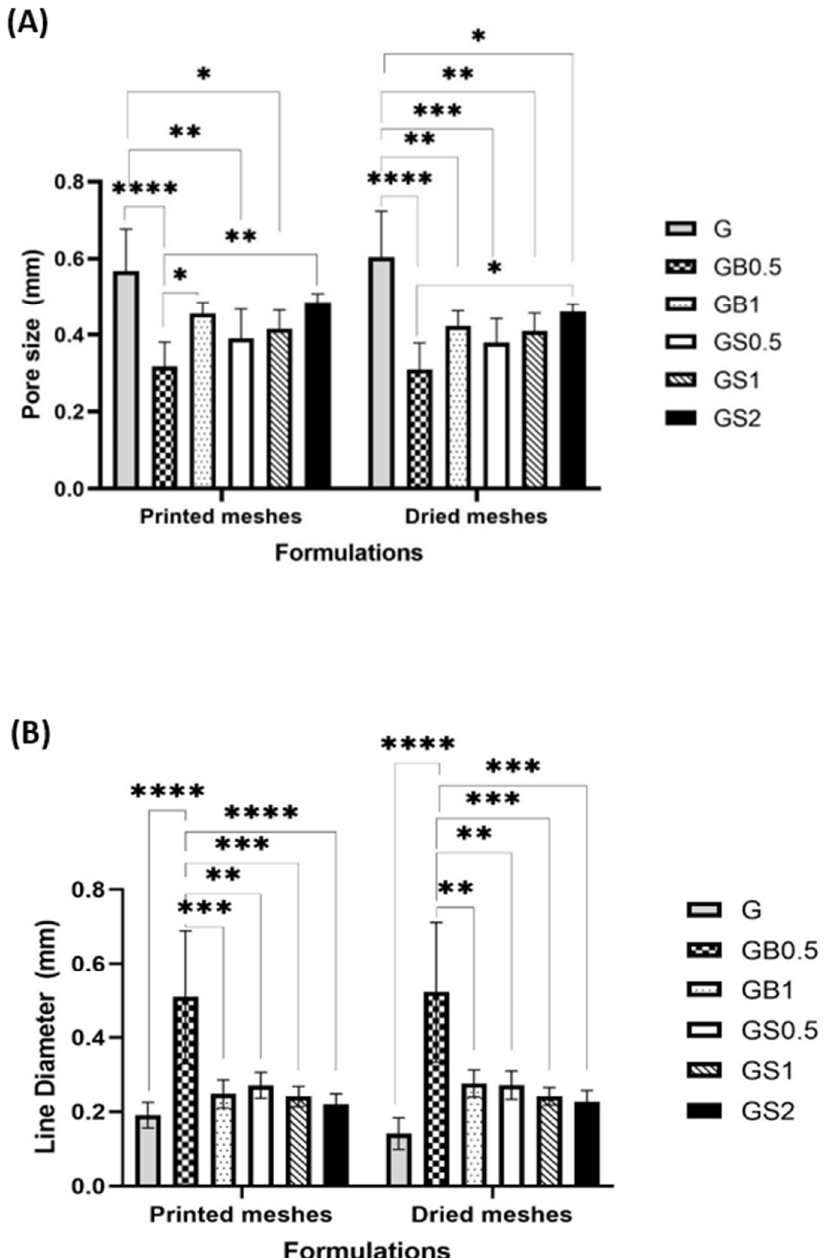
Figure 7. Comparison of ( A ) pore size and ( B ) line diameter of all the meshes before and after vacuum drying, printed using 25 G needles (**** p < 0.0001, *** p < 0.001, ** p < 0.01, * p < 0.05). The line diameter was found to be inversely associated with the pore size of the hy- drogel meshes; this is because the space occupied by thicker printed lines reduces the pore size of the printed mesh. Both printed and dried GB0.5 meshes were found to have larger diameter lines and smaller pores than other formulations. Thicker lines of GB0.5 resulted